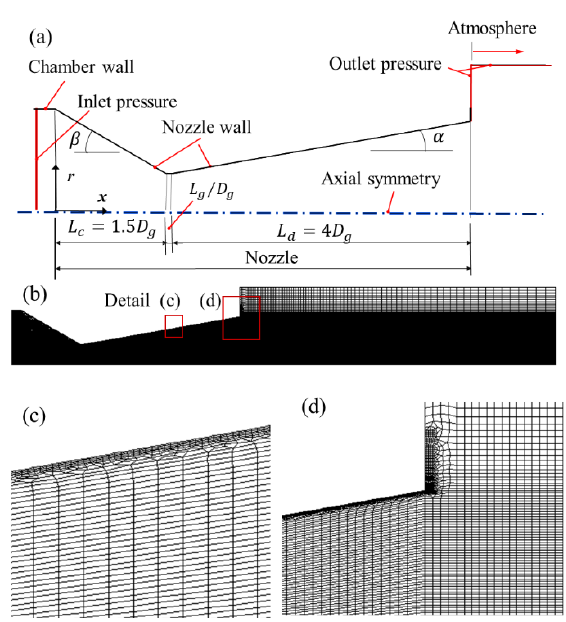
Figure 2. Conical nozzle geometry. (a) Computational domain and boundary conditions. (b) Meshed domain with 30813 elements. The enlarged detail (c) and (d) show the refined mesh in the wall region. Source: Authors.